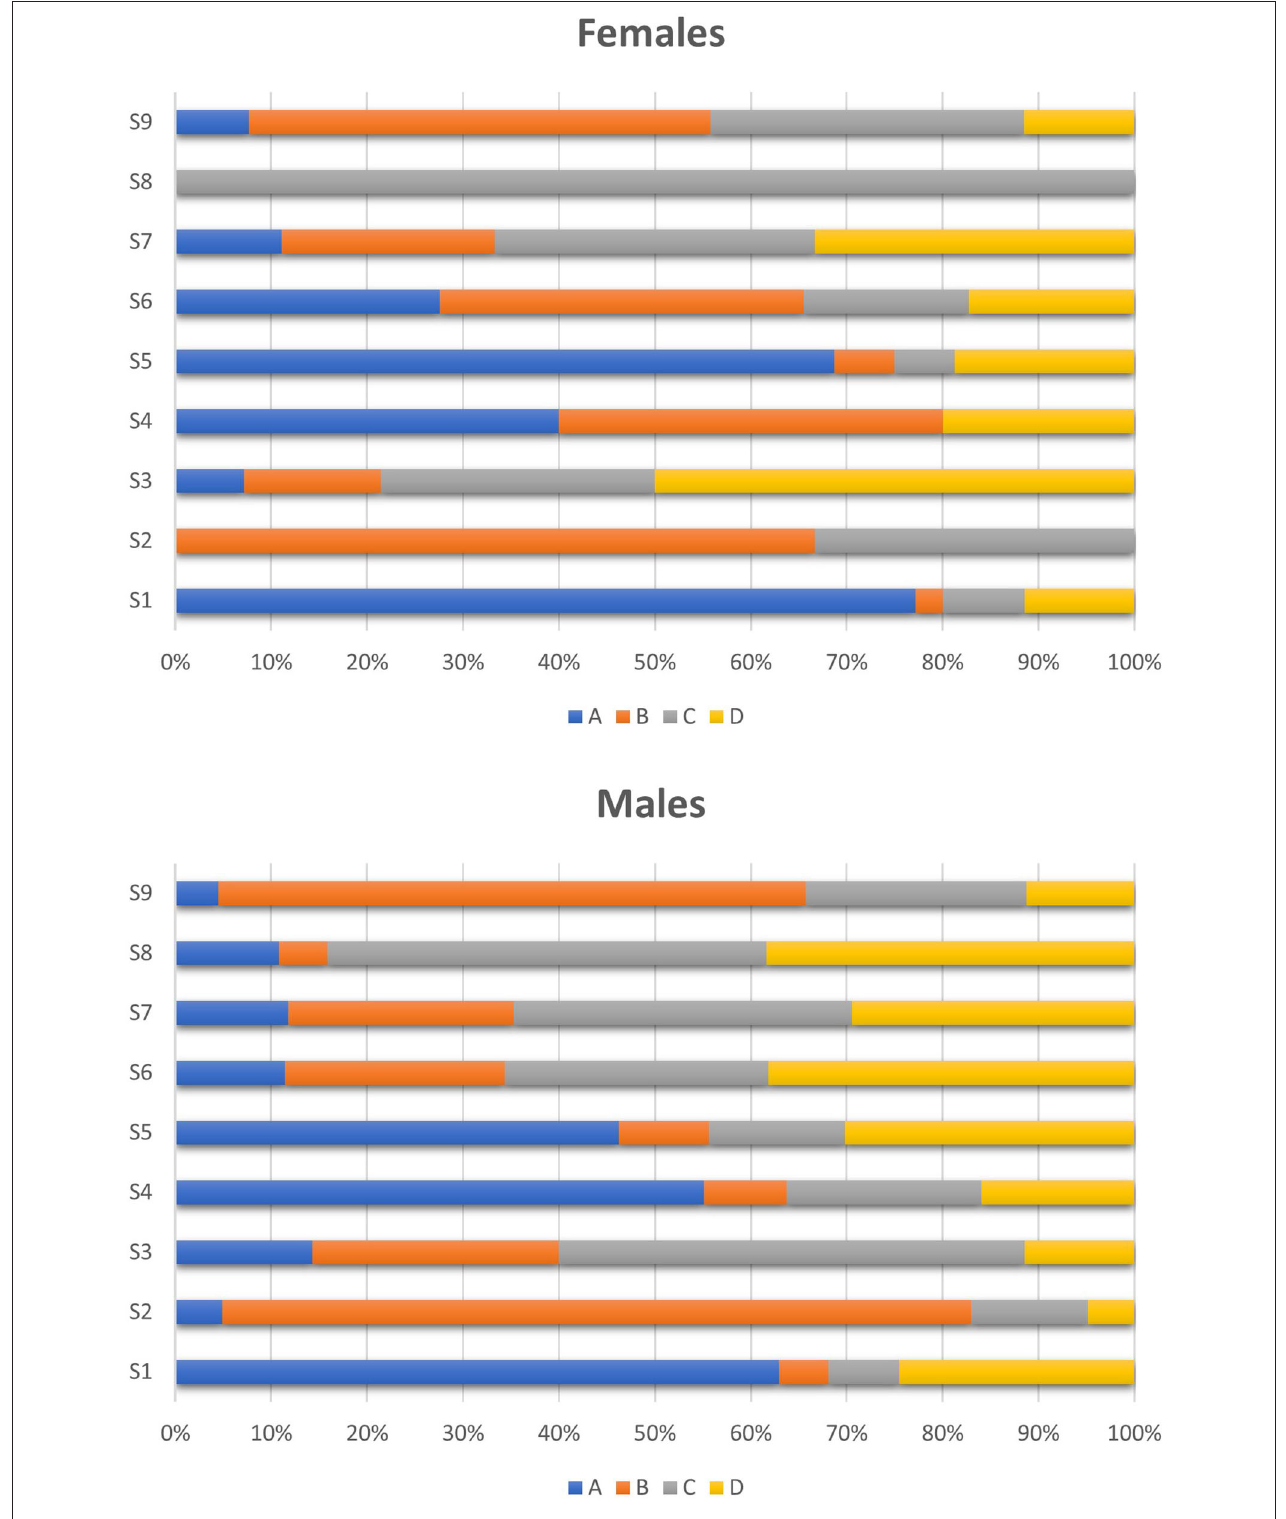
FIGURE 2 | Class use by women and men regarding the sports discipline. Group A: anaerobic sports (strength, power, and speed); Group B: aerobic sports (endurance); Group C: mixed aerobic/anaerobic sports; Group D: combat sports and others. S0, P1 and M2 were not represented, due to the too small number of AAFs, i.e., 0 for S0, 5 for P1 (3 men, 2 women) and 1 for M2 (1 woman).